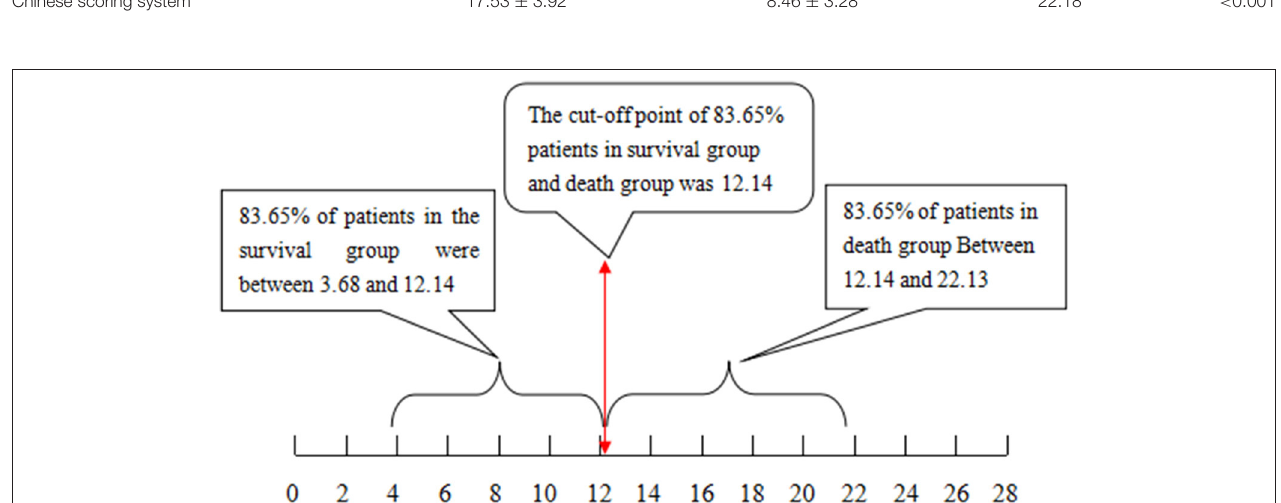
FIGURE 1 | The cutoff value and distribution range for the Chinese scoring system to separate the patients that survived from those that did not.